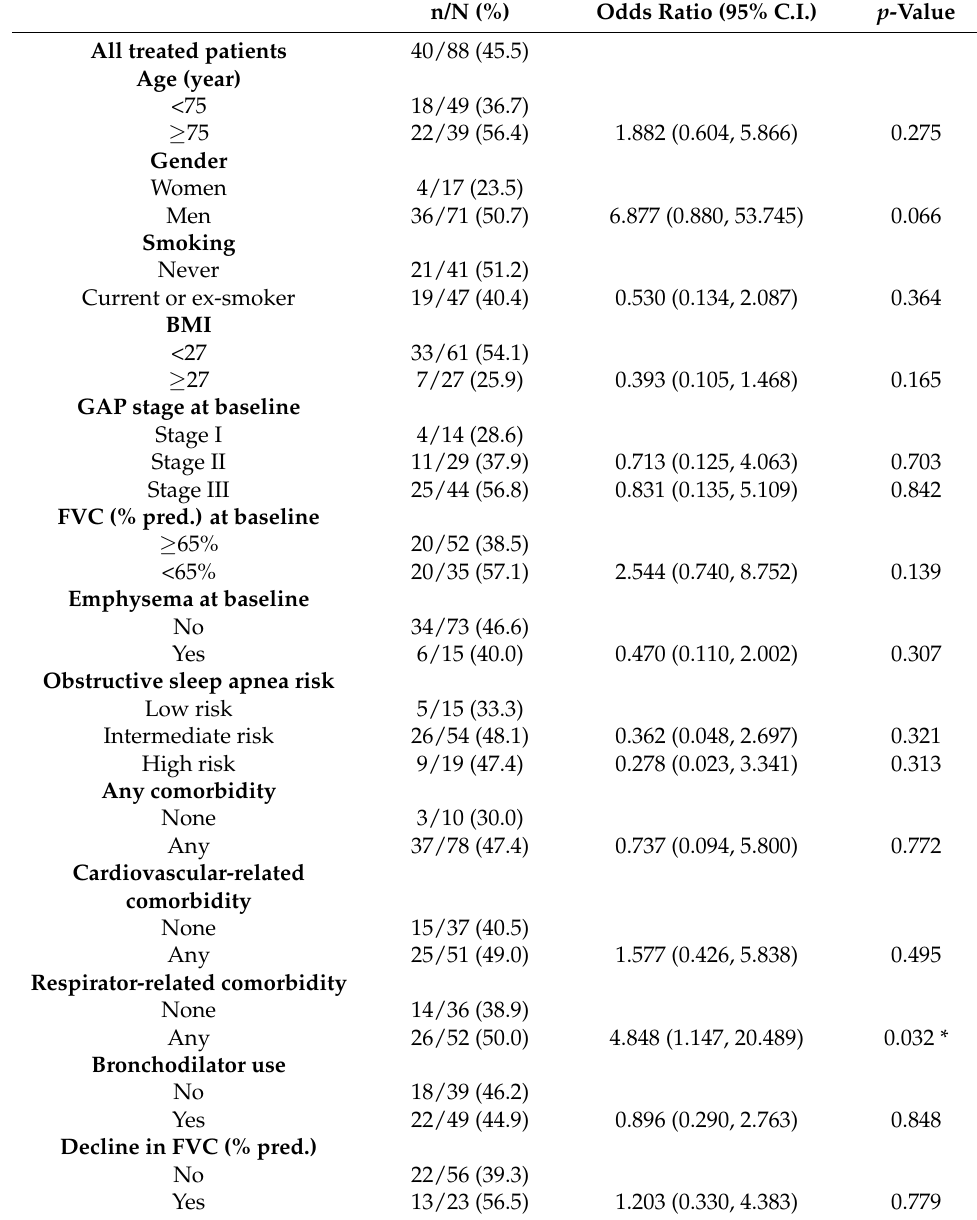
Table 4. Logistic regression analysis for acute exacerbation/death in treated patients between weeks